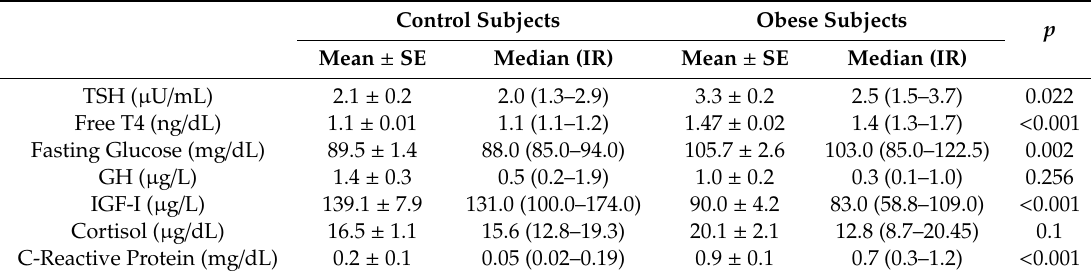
Table 2. Biochemical and hormonal data in control subjects and obese patients, (mean ± SE; median, interquartile